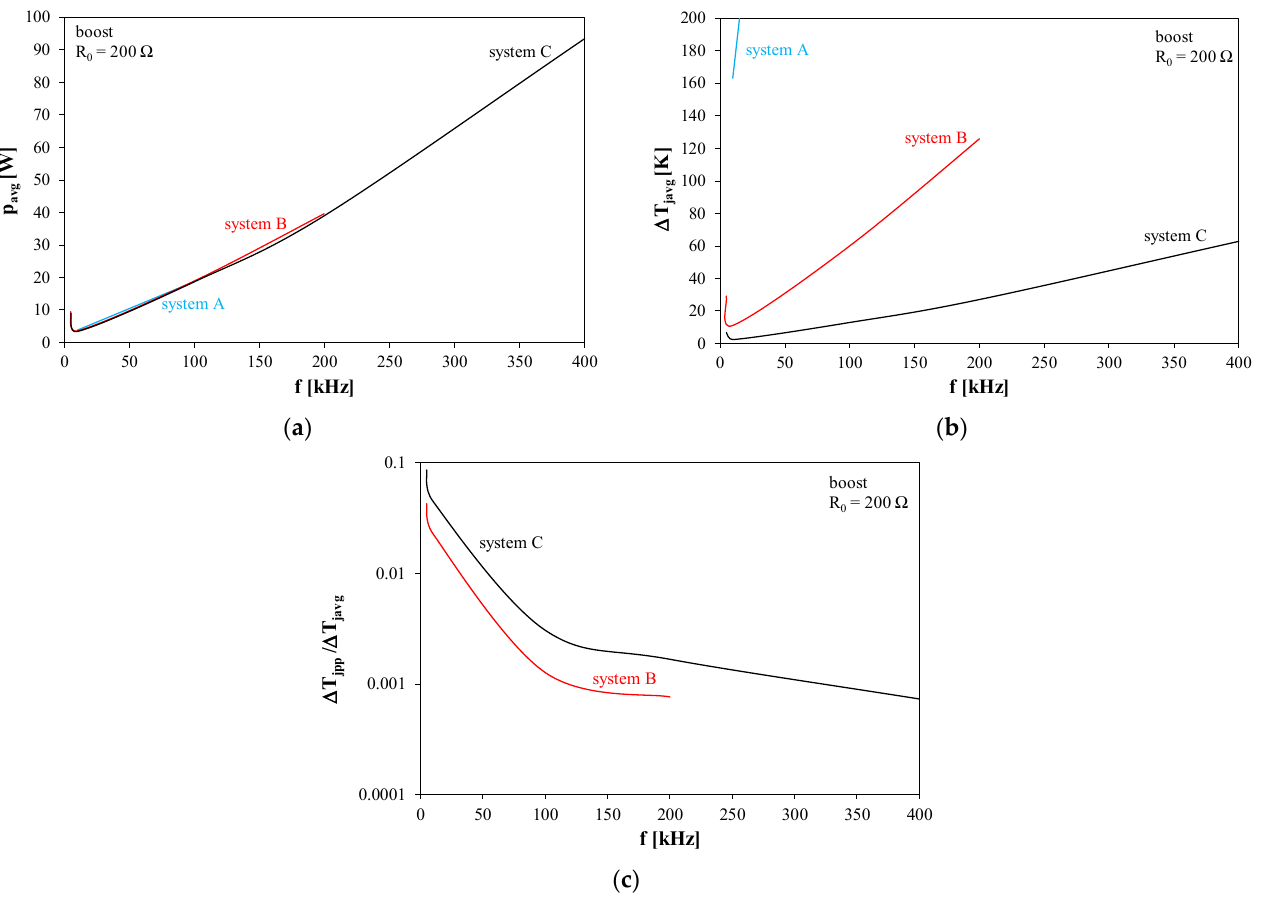
Figure 12. Dependence of the average power value ( a ), the excess of the junction temperature ( b ) and the quotient of the peak-to-peak value of ripples to the average value of the junction temperature ( c ) on frequency for the transistor operating in the boost converter and cooperating with different cooling systems.